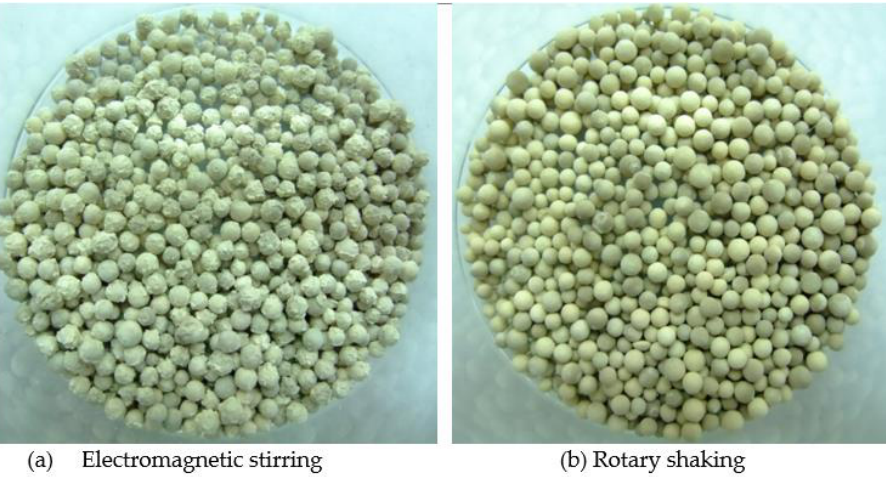
Figure 5. Surface of dehydrated molecular sieves after water-removal processes vibrated by ( a ) electromagnetic stirring and ( b ) rotary shaking.